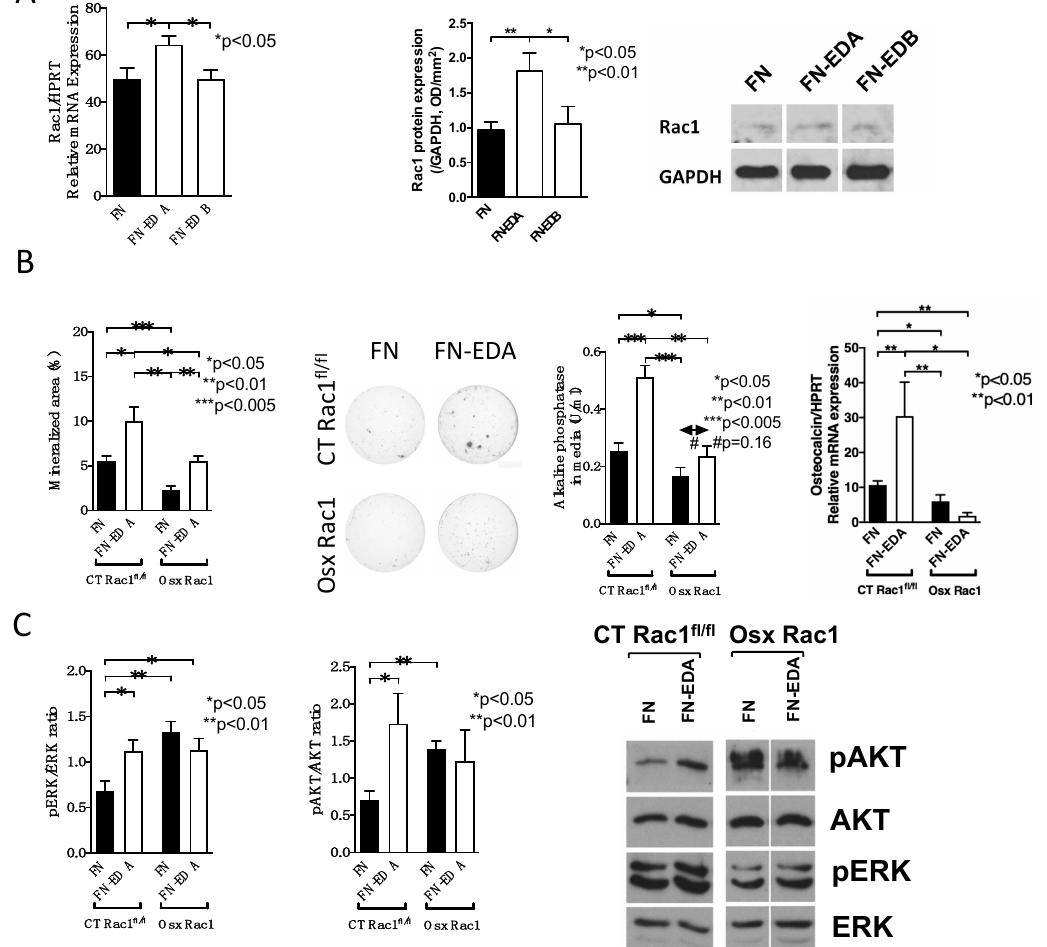
Figure 5. Conditional deletion of Rac1 in preosteoblasts interferes with integrin signaling. ( A ) Only transfection with fibronectin containing EDA (FN-EDA) increases Rac1 mRNA and protein expression. n = 8/7/7 and 10/9/6. Rac1 mRNA was adjusted to HPRT and Rac1 protein to GAPDH. ( B ) Transfection with FN-EDA enhances mineralization in CT Rac1 fl/fl and in Osx Rac1 osteoblasts. Unlike CT Rac1 fl/fl cells, however, alkaline phosphatase in the media and osteocalcin mRNA do not respond in Osx Rac1. Newborn calvarial osteoblasts were isolated, transfected with the FN or FN-EDA construct and cultured for 2–3 weeks in mineralizing conditions in the presence of vitamin C, β -glycerophosphate, and dexamethasone added fresh with each medium change (3 times/week). At the end, the wells were stained using von Kossa stain and the media evaluated for alkaline phosphatase. Osteocalcin/HPRT mRNA was evaluated in sister wells that were not stained or in separate experiments and corrected to the housekeeping gene HPRT. Mice were not exposed to doxycycline at any time. n = 7/6/5/7, 6/5/5/4, 10/3/8/3. ( C ) ERK and AKT phosphorylation increased upon transfection with FN-EDA in CT Rac1 fl/fl cells. In Osx Rac1 the phosphorylation of both increased with FN and did not increase further with FN-EDA. Cells were transfected and left two days before collecting the cell lysate for Western blotting. n = 7/6/9/12, 7/7/5/7. ANOVA was performed and whenever significant, the values were compared between every two groups in all subpanels using t- tests. In summary, the absence of Rac1 in newborn calvarial osteoblasts diminishes their differentiation but does not prevent the improvement that is mediated by integrin activation, even though alterations in intracellular signaling can be detected.